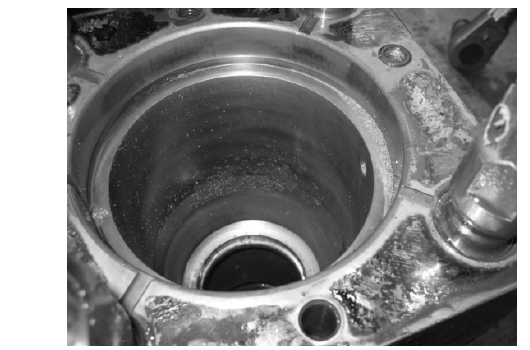
Figure 7 – Housing of the hammer with